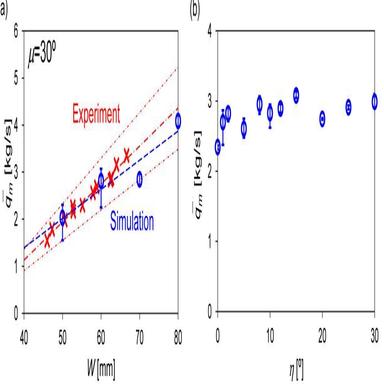
(a) Comparison of predicted average mass flow rates (blue circles) for different hopper outlet widths W to physical measurements (red 'x's). The dot-dashed lines in red represent ±20%-error boundaries. (b) Predicted average mass flow rate from the numerical model as a function of wall friction angle. Uncertainty bars on the numerical results represent the standard deviation due to a reasonable range of time increment sizes Δt.